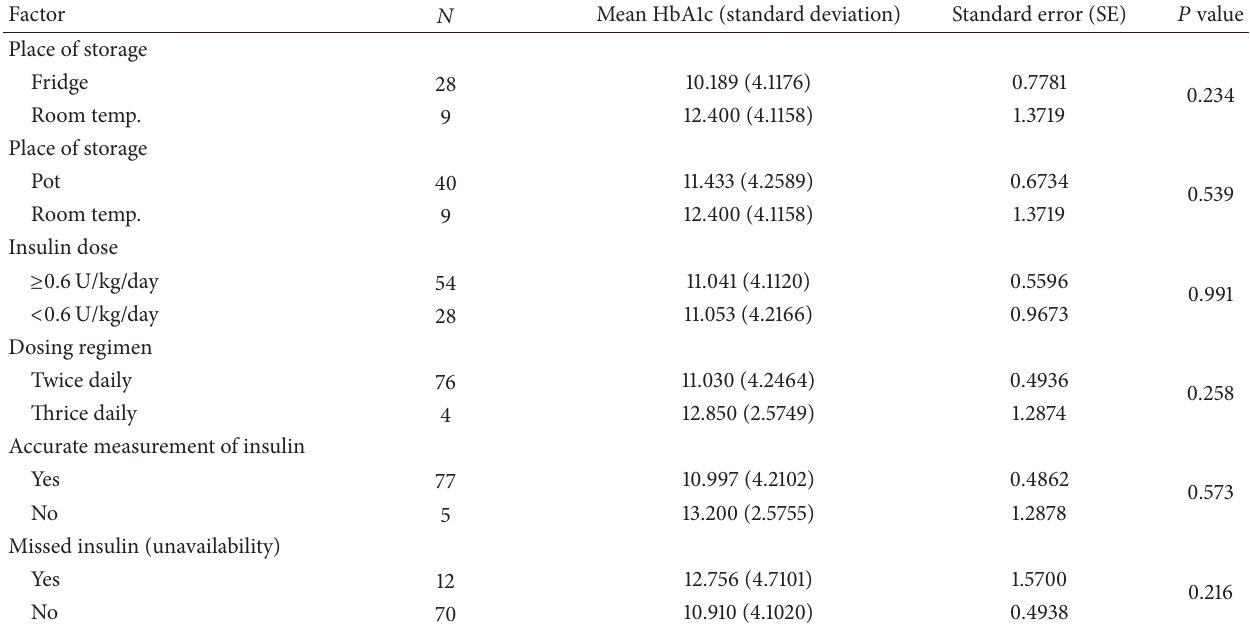
Table 2: Insulin handling and glycemic